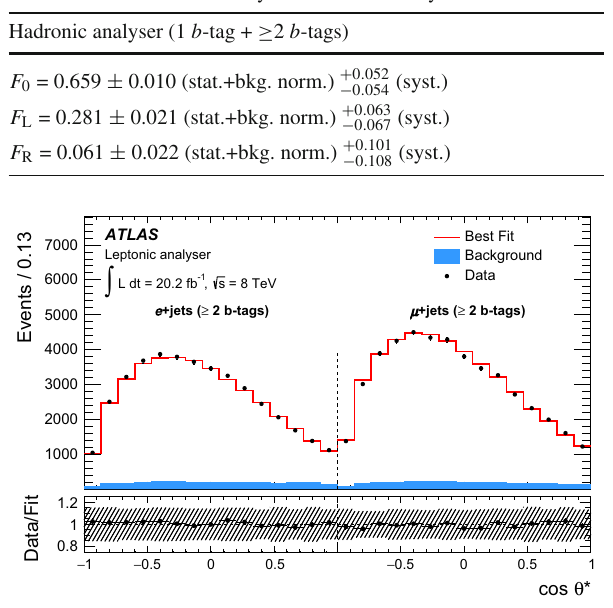
Fig. 4 Post-fit distribution of cos θ ∗ for the leptonic analyser with ≥ 2 b -tags, in which a two-channel combination is performed (electron and muon). The uncertainty band represents the total uncertainty in the fit result